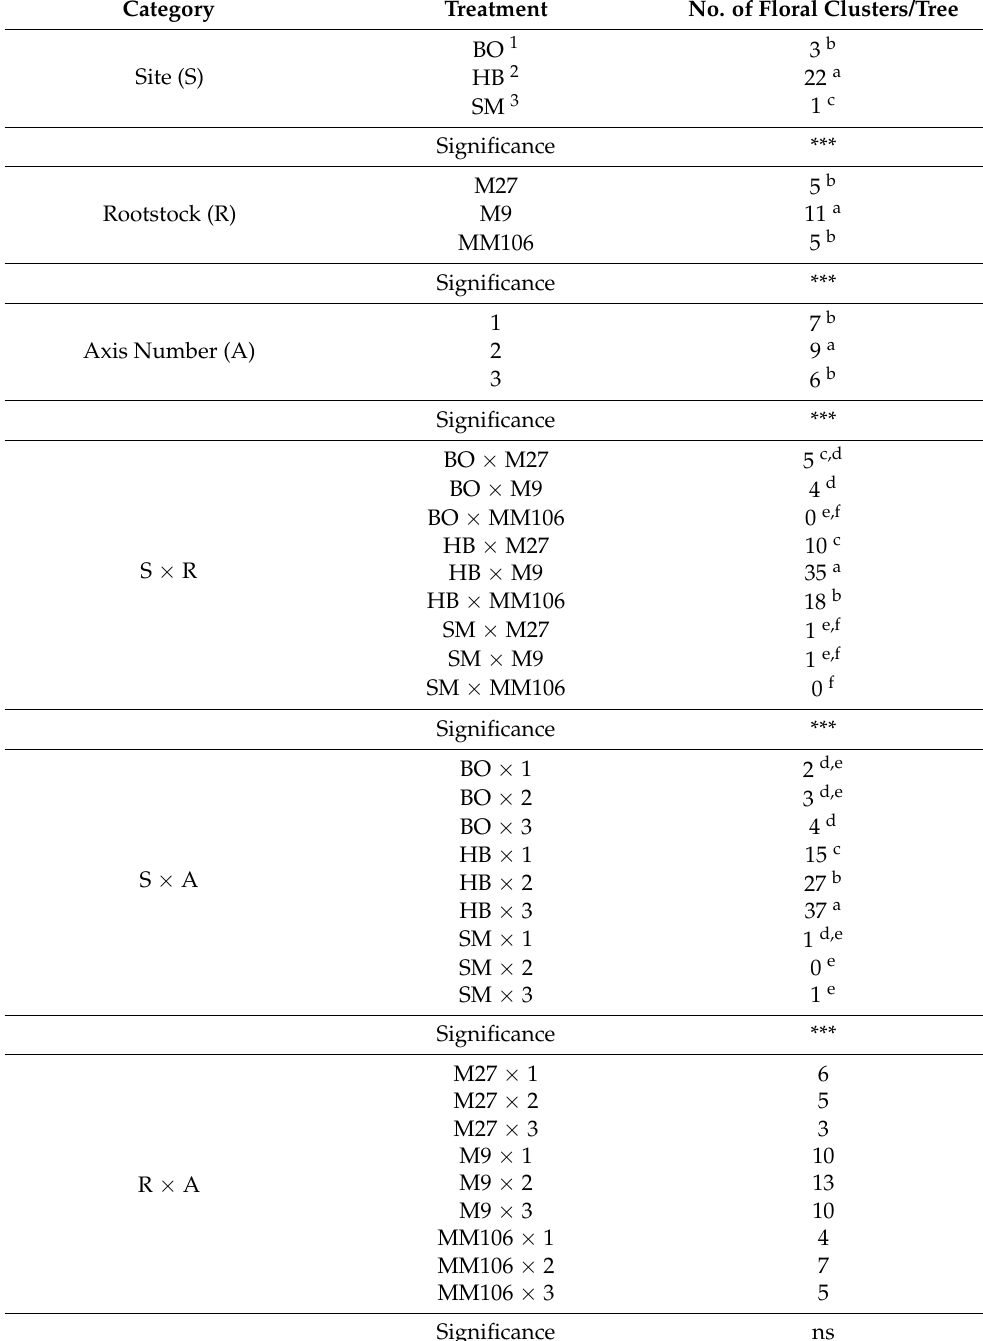
Table 8. Main effects of site of cultivation, rootstock, axis number, and their interactions on the number of floral clusters per tree in ‘Fuji’